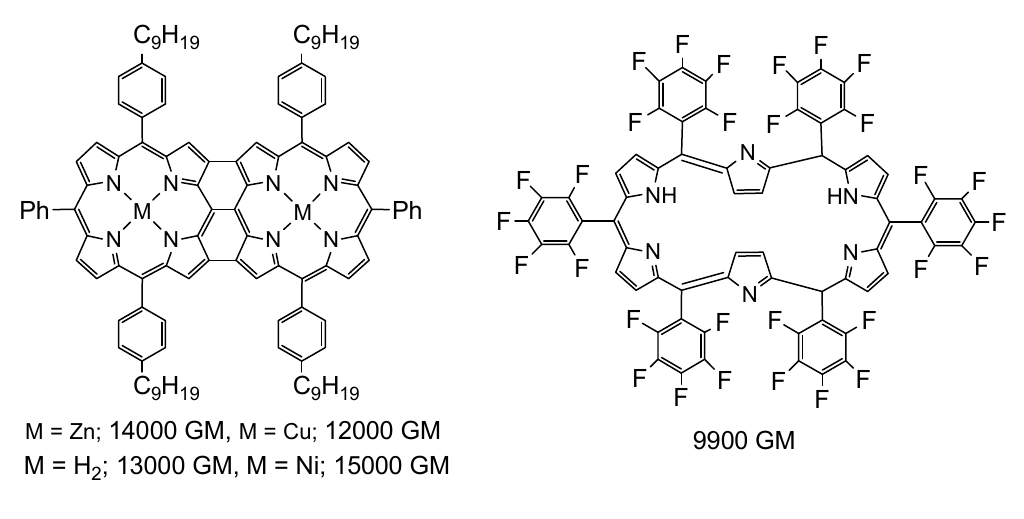
Scheme 5. Photochromic